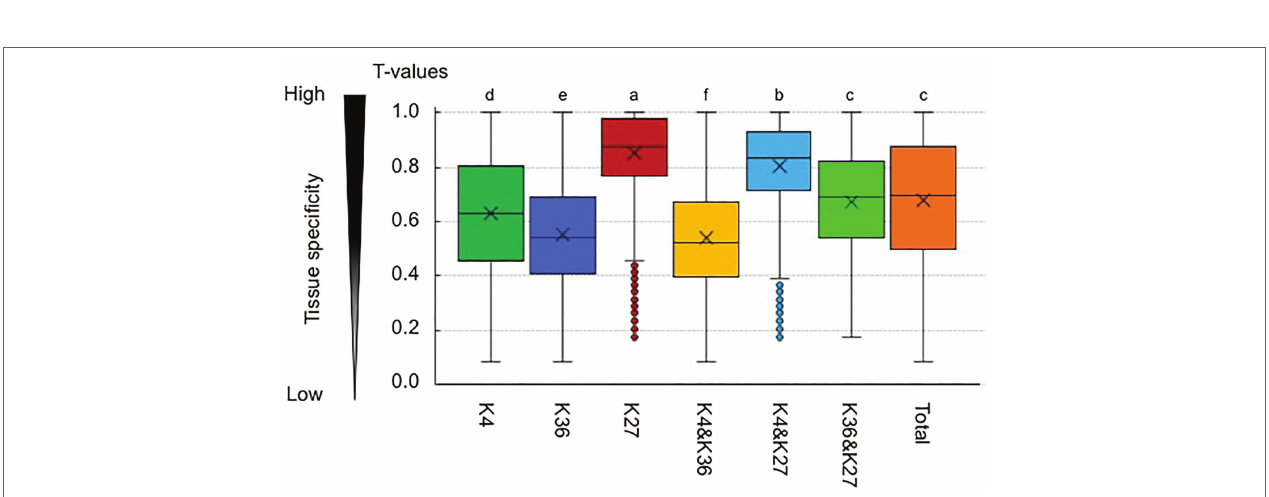
FIGURE 5 | Tissue specificity of expression in genes having an H3K4me3 (K4) or H3K36me3 (K36) mark. A tissue specificity index, T -value, which interpolates the entire range between 0 for housekeeping genes and 1 for strictly one-tissue-specific genes, was calculated using the transcriptome data in six different tissues in B. rapa . K27 represents the H3K27me3-marked genes. “&” represents genes having two different histone marks. “Total” indicates T -value in all genes. Different letters indicate significant difference (Tukey’s HSD test, p < 0.05).